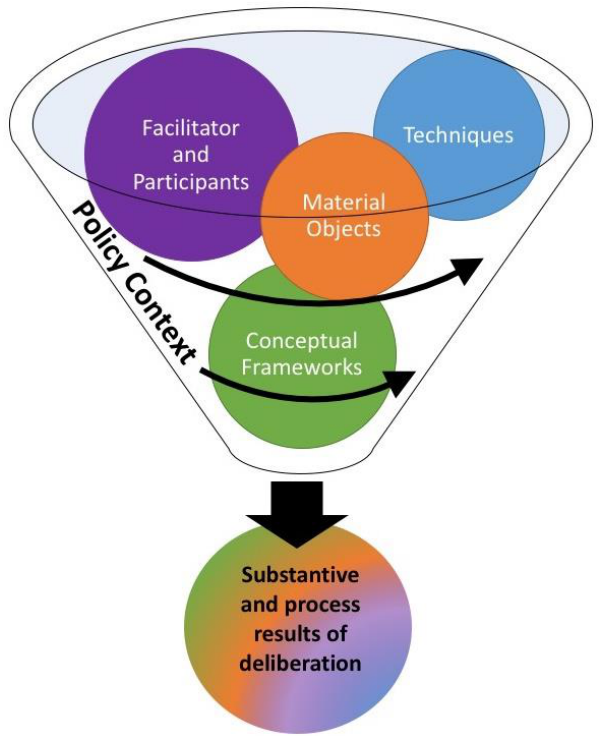
Figure 1. Deliberative technologies emerge from dynamic interactions among techniques, material objects, conceptual frameworks, facilitators and participants, and the policy